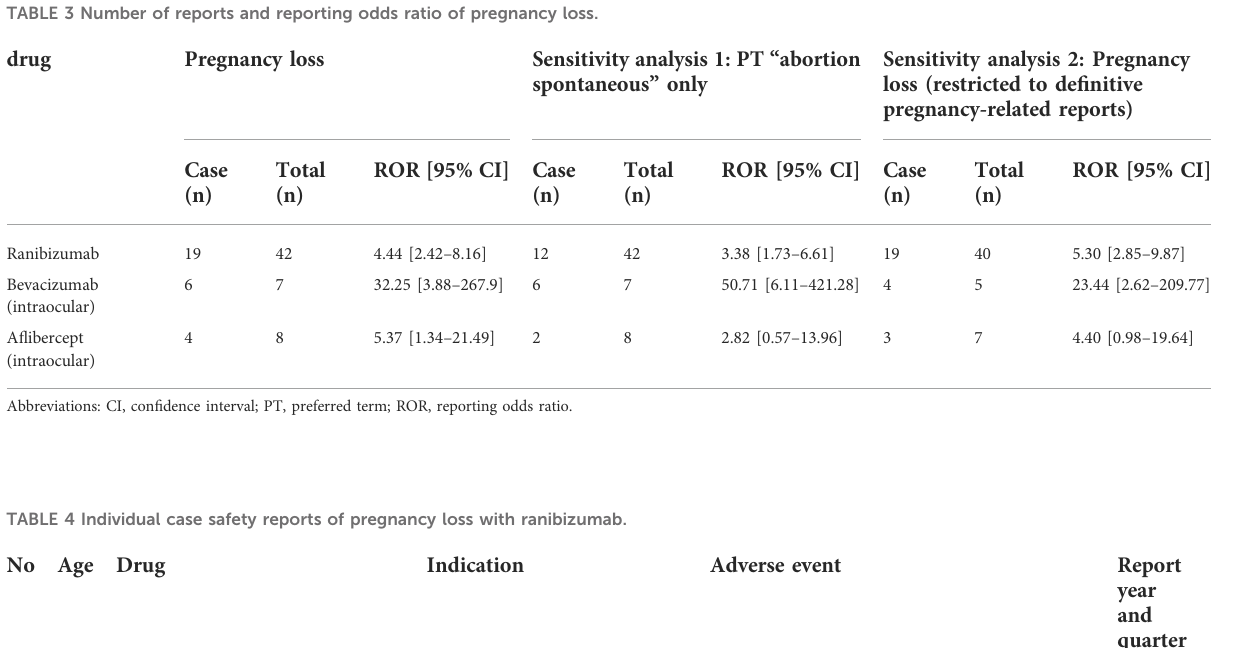
TABLE 3 Number of reports and reporting odds ratio of pregnancy